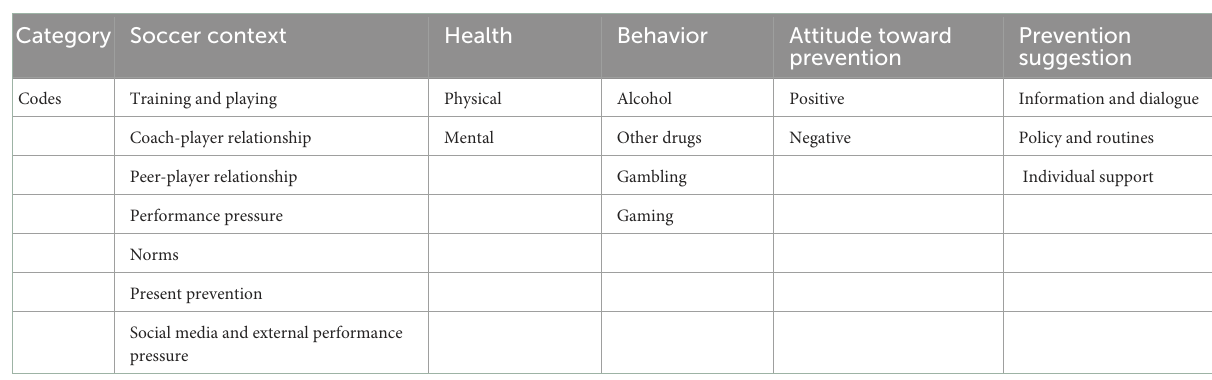
TABLE 3 Final coding